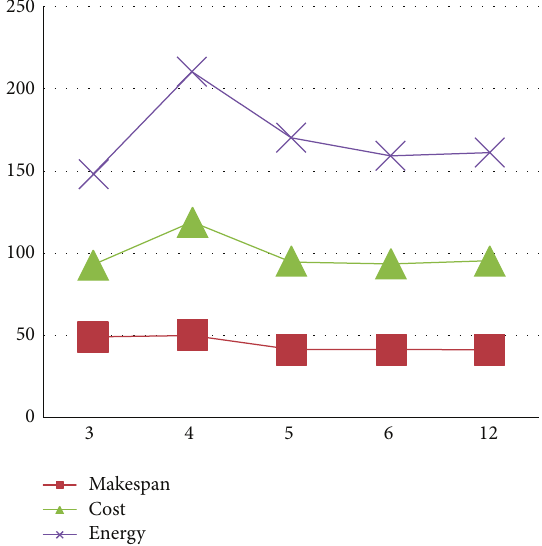
Figure 9: QoS metrics evolutions according to resource numbers for the synthetic workflow. Table 4: Improvement according to real world applications.